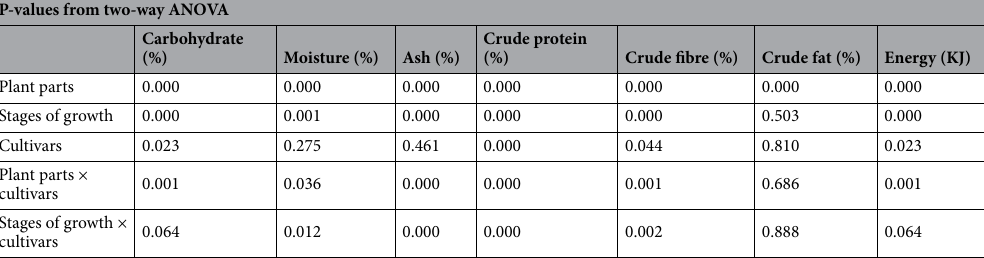
Table 2. ANOVA analysis of nutritional components of